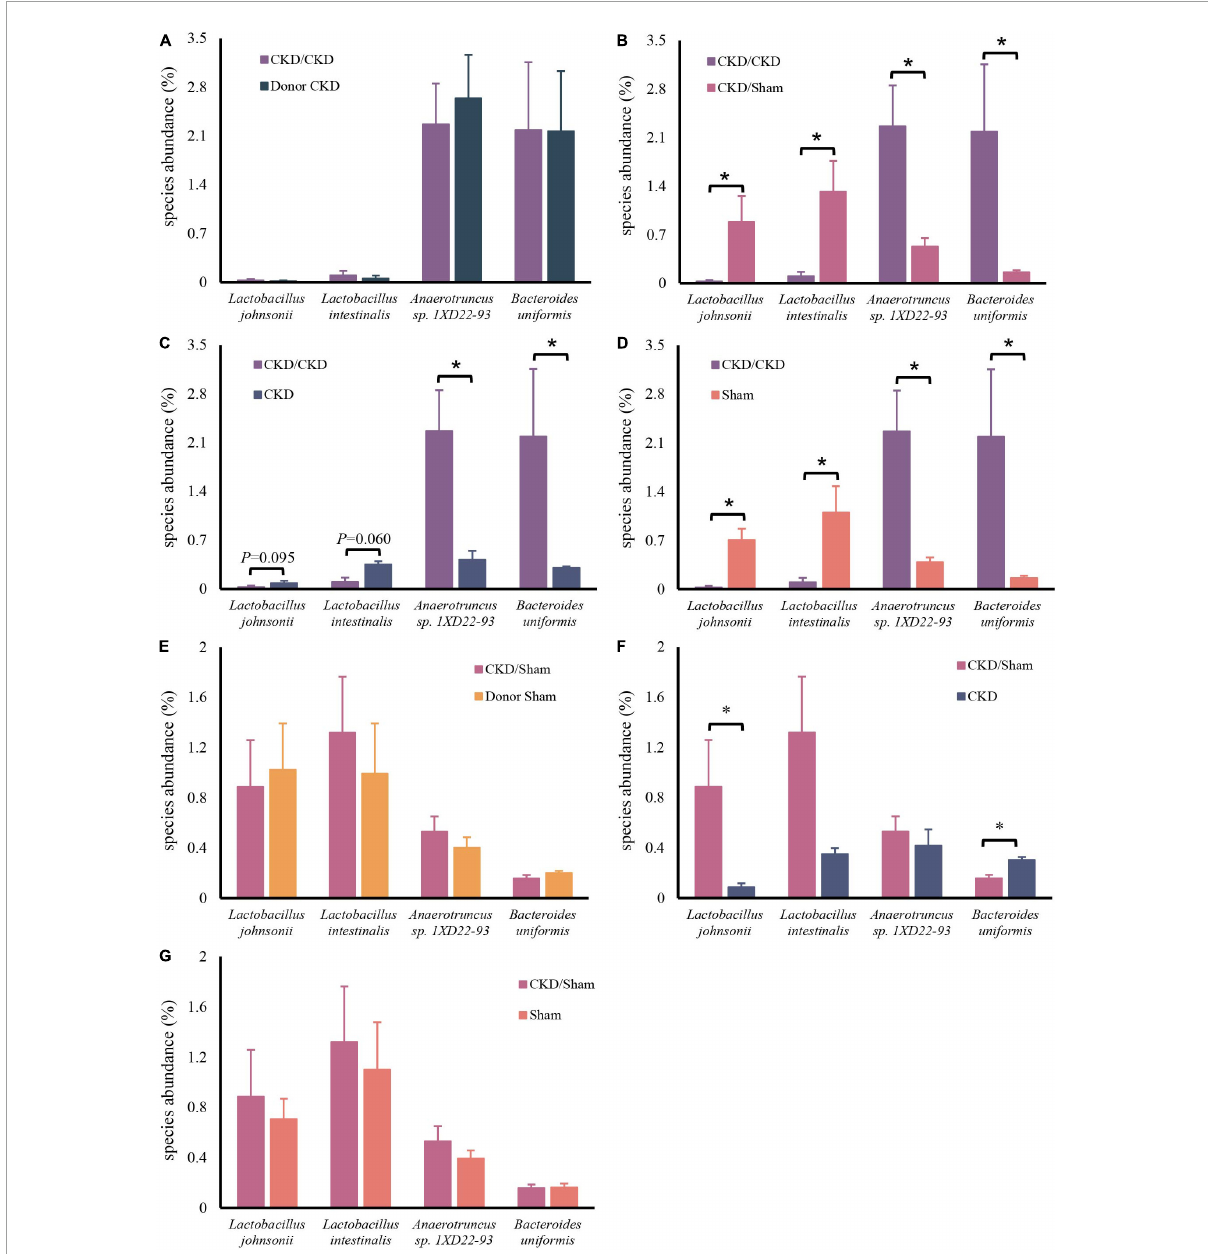
FIGURE6 Differentially expressed species abundance among rats. (A) CKD/CKD VS Donor CKD. (B) CKD/CKD VS CKD/Sham. (C) CKD/CKD VS CKD. (D) CKD/CKD VS Sham. (E) CKD/Sham VS Donor Sham. (F) CKD/Sham VS Sham. (G) CKD/Sham VS CKD. The data is presented as means ± SEM. Donor Sham, n = 5; Donor CKD, n = 5; CKD/CKD, n = 5; CKD/Sham, n = 5; Sham, n = 5; CKD, n = 5. * P <